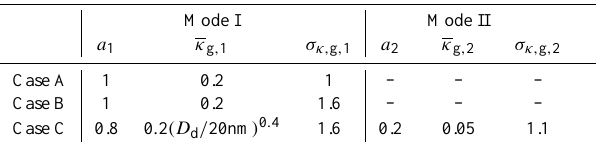
Table 1. Lognormal hygroscopicity distribution parameters for model aerosols (Cases A to C, Eq.